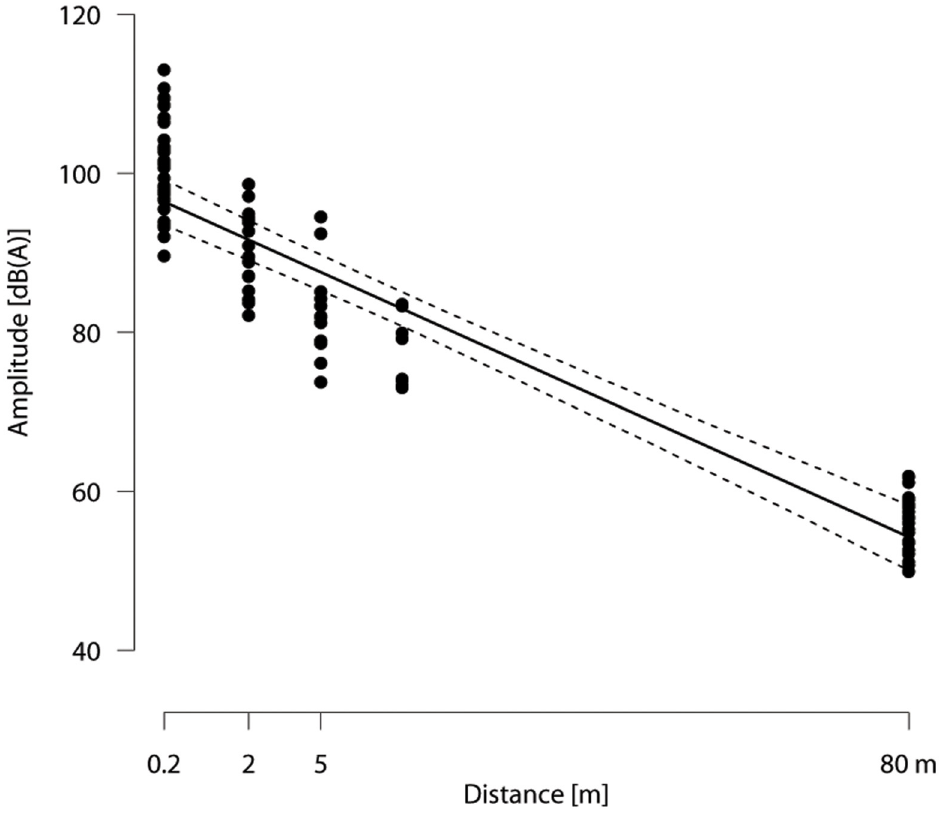
Fig 2. Amplitudes of the bells at distances up to 80 m [dB(A)]. Solid line: model estimate, dashed lines: 95% intervals of confidence based on a model predicting amplitude by the square root of the distance, controlling for bell identity and multiple measurements per